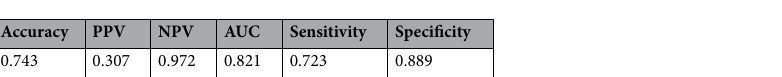
Table 3. Results of ROC curve analysis on POD 4 (cutoff value, 180 mg/L). AUC, area under the curve; NPV, negative predictive value; POD, postoperative day; PPV, positive predictive value; ROC, receiver operating